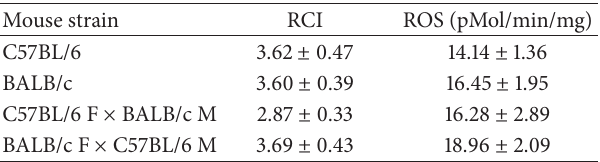
Figure 2: mtDNA to nDNA ratios in livers of C57BL/6, BALB/c, and F1 hybrids. A significant difference ( 𝑃 < 0.01 ) existed between C57BL/6 and BALB/c mice. The mtDNA to nDNA ratios of the F1 hybrids were higher than those of BALB/c mice but lower than those of C57BL/6 mice. Table 1: RCI and ROS measured in isolated hepatic mitochondria from C57BL/6 and BALB/c mice and their F1